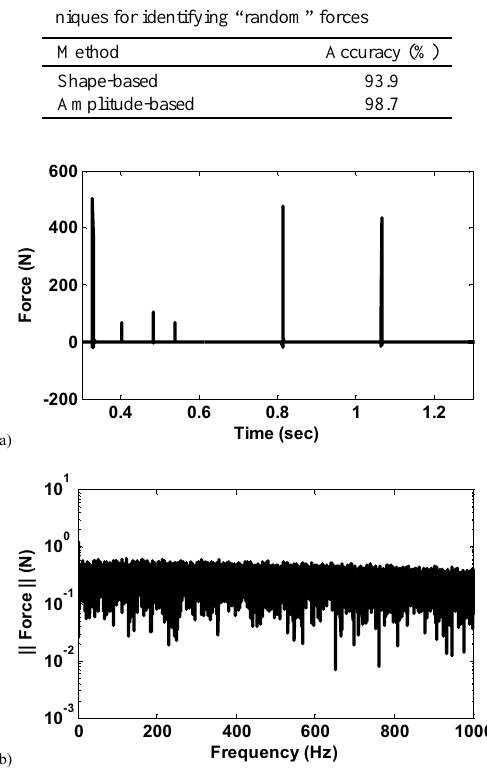
Fig. 16. An example of a “random” impact force in the a) time and b) frequency